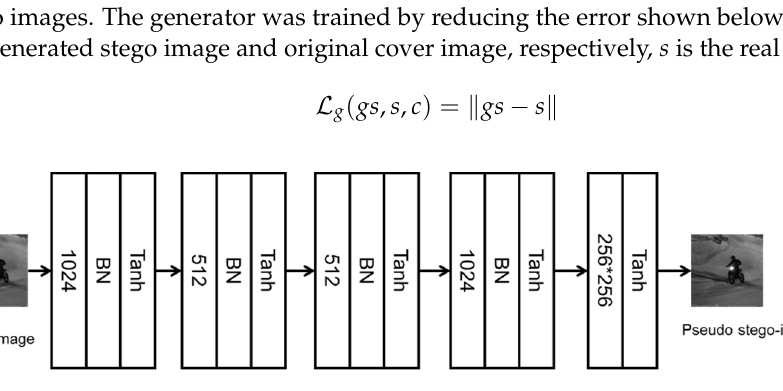
Figure 3. Structure of the CNN generator. Figure 4. S tructure of the RES generator. 2.2. Details of the Generator The RES generator borrows heavily from SRNet [16], however, there are three im- provements for this special application: (1) A new type of normalization layer was de- signed to preserve the fragile pseudo stego signals. (2) Three shortcut connections from the input to three types of output layers were added to enhance the learning of the differ- ence between cover image and stego image, as depicted in Figure 4. (3) The ReLU activa- tion function was replaced with Tanh to produce negative signals as in the stego image. Such a structure can better preserve the noise-like stego signals. The RES generator consisted of 12 layers, as shown in Figure 4, and the details of each layer of the generator are shown in Table 1. Table 1. D etails of each layer of the generator. Input